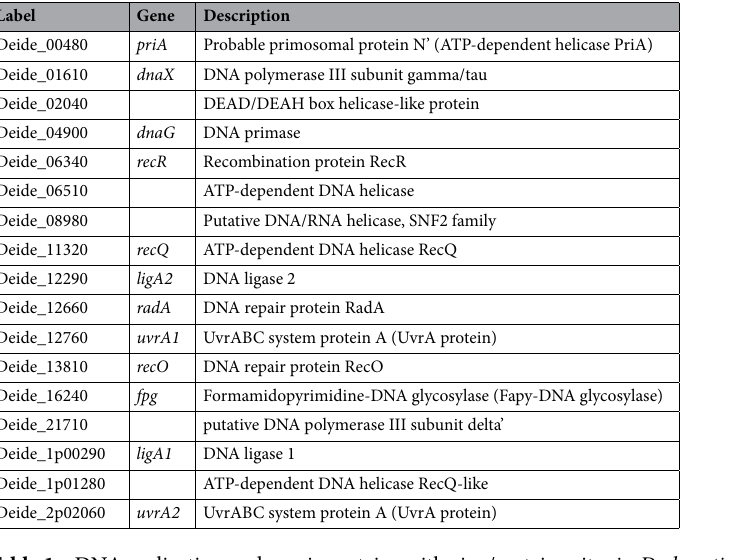
Table 1. DNA replication and repair proteins with zinc/cysteine sites in D. deserti